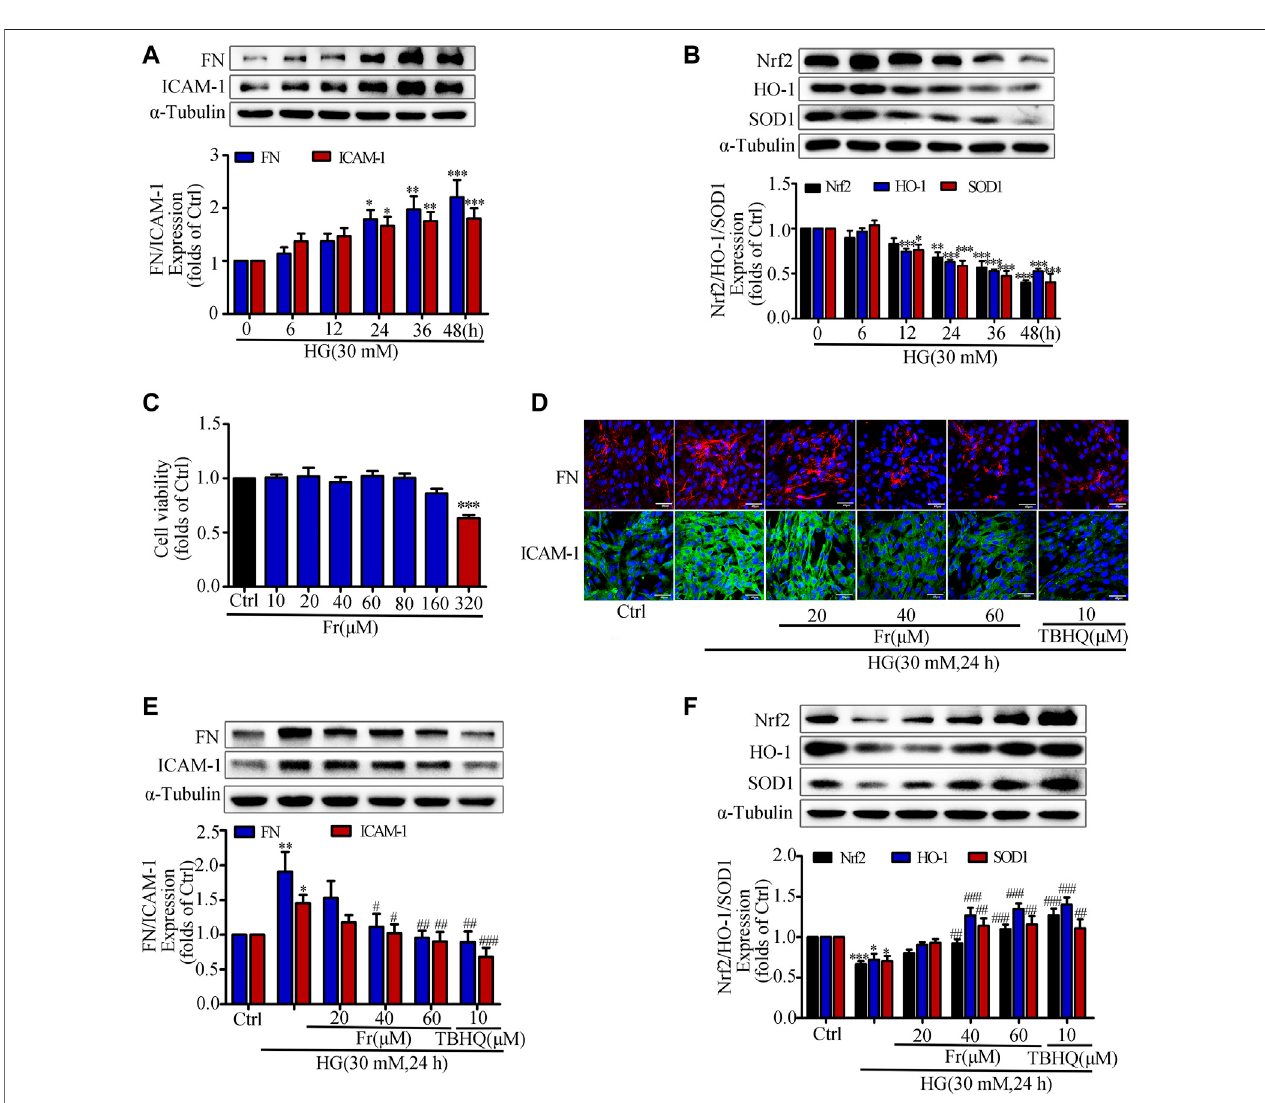
FIGURE 1 | Fr suppressed the development of in fl ammatory fi brosis factors by boosting the expression of antioxidant enzymes in high glucose induced GMCs. (A-B) The protein expression of FN, ICAM-1, Nrf2, HO-1 and SOD1 in GMCs were measured by western blot assay, * p < 0.05, ** p < 0.01, *** p < 0.001 vs . 0 h. (C) Cell survivalanalysis through MTTassay ofGMCswastreatedwithdifferent concentrationsofFrfor 24h, *** p < 0.001 vs .Ctrl. (D) The cellular distributionofFN and ICAM-1 was untreated or treated through Immuno fl uorescence (magni fi cation ×400). Bar: 40 μ m. The red and green fl uorescence represent the localization of FN and ICAM-1 respectively. (E-F) The protein levels of FN, ICAM-1, Nrf2, HO-1 and SOD1 in GMCs were measured through western blot assay, * p < 0.05, ** p < 0.01, *** p < 0.001 vs . Ctrl; # p < 0.05, ## p < 0.01, ### p < 0.001 vs . HG. Independent experiments were performed at least three times with similar results.